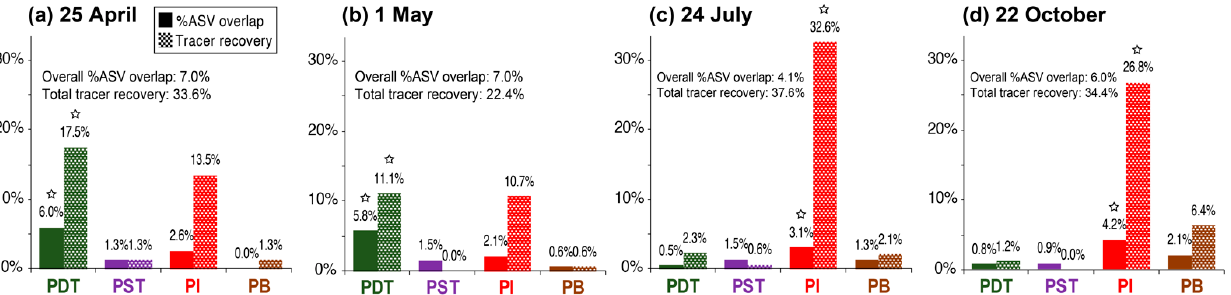
Figure 7. Percentage ASV overlap (as defined in Figure 6) in each producing well near the tracer campaign on 25 April ( a ), 1 May ( b ), 24 July ( c ), and 22 October ( d ), with tracer recoveries of each well included alongside for ease of comparison. Stars in the bar charts denote the largest single-well %ASV overlap or tracer mass recovery near or in each tracer campaign. Values of overall %ASV overlap, and total tracer recoveries of each tracer campaign are also indicated on each subfigure.